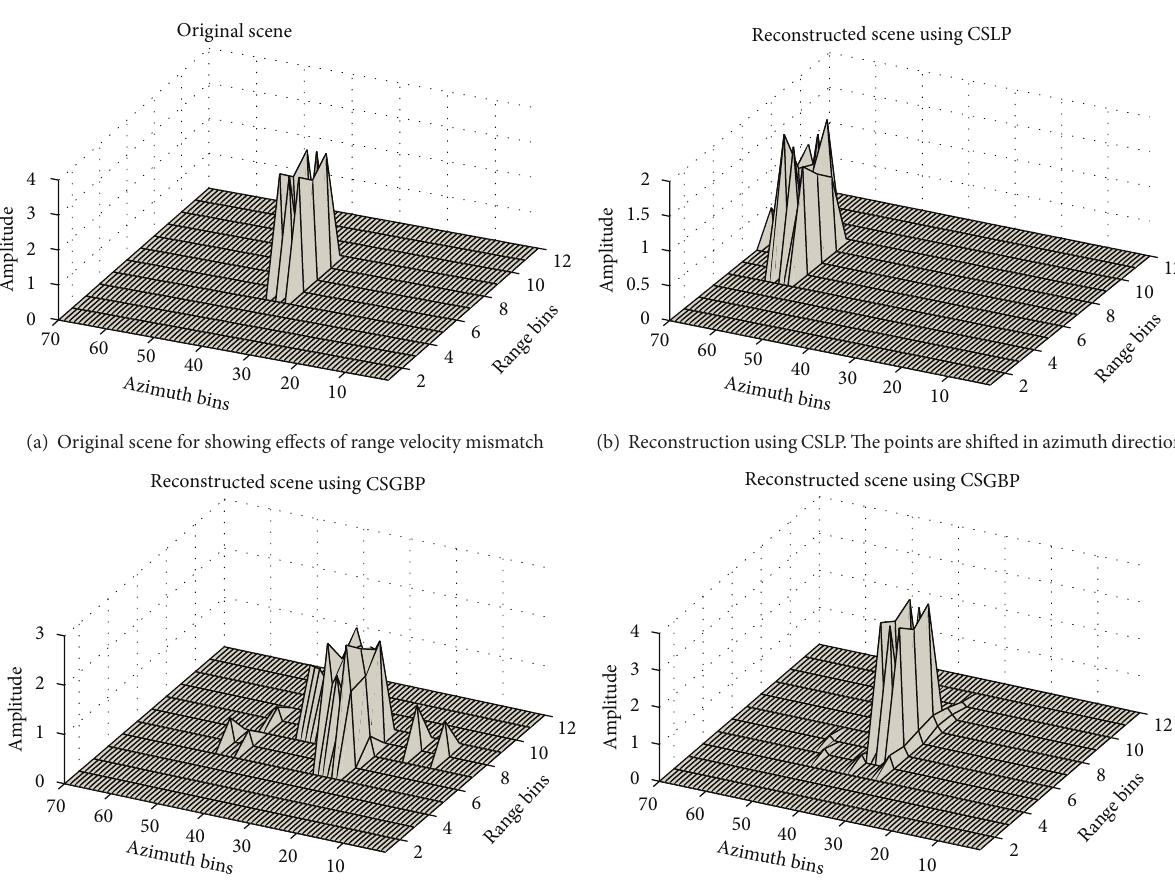
Figure 7: Reconstruction using CSLP, CSGBP, and iterative CSGBP in the presence of range velocity mismatch.